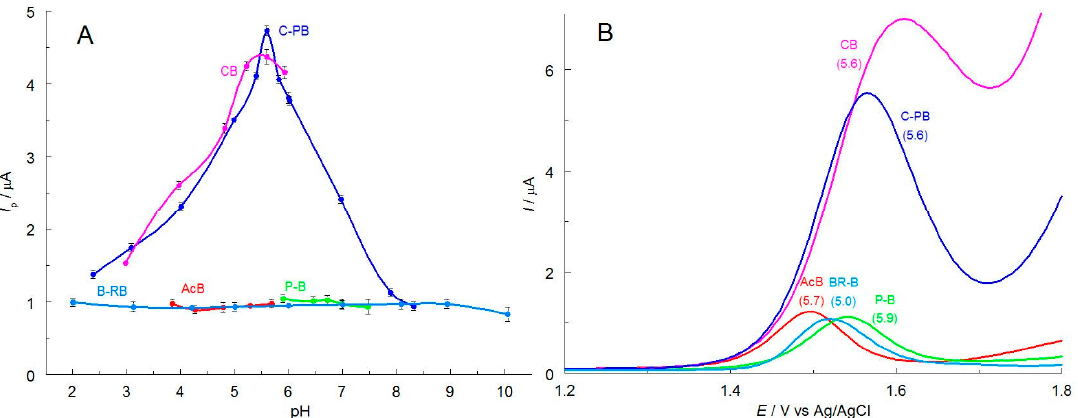
Figure 1. ( A ) Relationship between MIT (10.38 mg L − 1 ) oxidation peak current, I p and the pH obtained in buffer solutions: B-RB, AcB, PB, CB, and C-PB on BDDE. ( B ) DPV curves (d E = 20 mV) recorded in tested solutions at pH (given in parenthesis) guaranteeing the maximum value of the peak current.